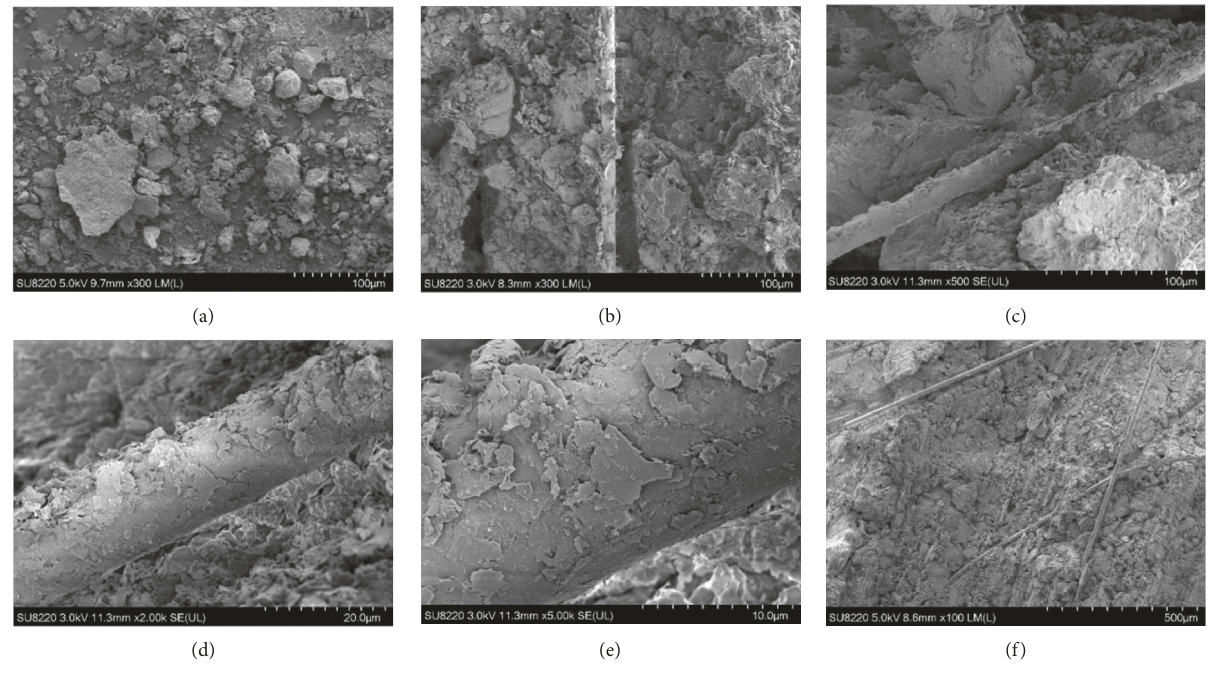
Figure 6: SEM of test